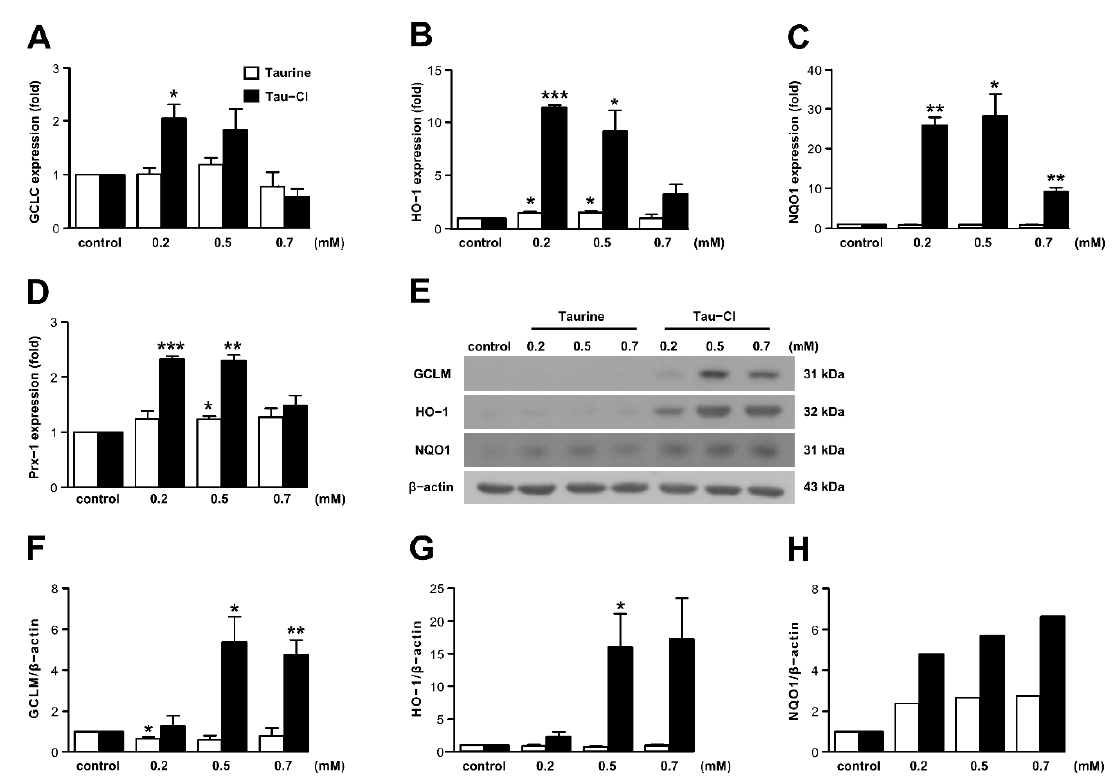
Figure 4. Tau-Cl increased the expression of antioxidant enzymes in BV2 cells. ( A – D ) BV2 cells were treated with various concentrations of taurine and Tau-Cl. The expressions levels of glutamate–cysteine ligase catalytic (GCLC) subunit ( A ), heme oxygenase-1 (HO-1) ( B ), NADPH:quinone oxidoreductase-1 (NQO1) ( C ), and peroxiredoxin-1 (Prx-1) ( D ) mRNA were determined by qRT-PCR (n = 4). ( E – H ) The protein levels of glutamate–cysteine ligase modifier (GCLM) subunit, HO-1, and NQO1 were determined by immunoblotting, and blots quantified by using the Image J software are presented as arbitrary density units ( F – H ) (n = 3). A representative arbitrary density of NQO1 from one of three independent experiments is shown in ( H ). Results are presented as mean ± SEM, * p < 0.05, ** p < 0.01, and *** p < 0.01 vs. control by a two-tailed Student’s t -test.